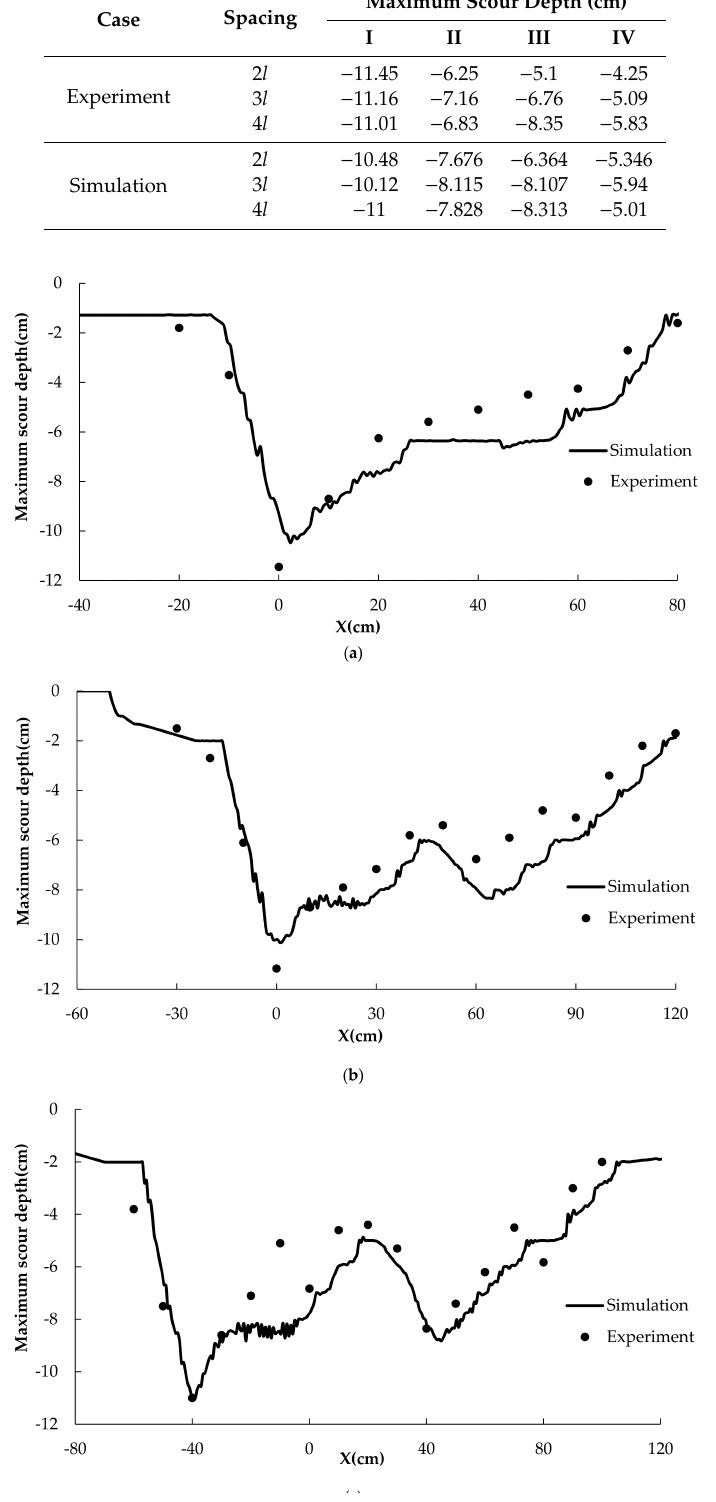
Figure 6. The local scour depth at the spur dike head. ( a ) for 2 l spacing; ( b ) for 3 l spacing; ( c ) for 4 l